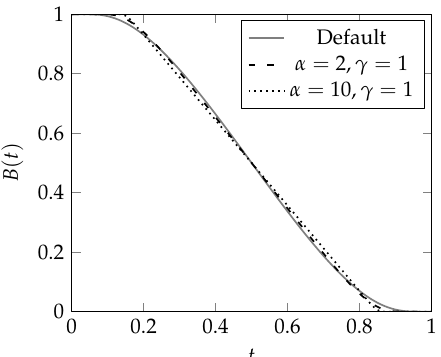
Figure 7. Plot of the default ERB-function. Figure 8. Plots of ERB-functions with Figure 8. Plots of Expo-rational blending functions (ERB-functions) with varying tightening parameters. varying tightening parameters. The solid The solid function is the default ERB ( α = γ = 1), the dashed function has α = 2 and γ = 1, and the function is the default ERB ( α = γ = 1), the dotted function has α = 10 and γ = dashed function has α = 2 and γ = 1, and Figure 9. Plots of ERB-functions with the dotted function has α = 10 and γ = 1. varying slope parameters. The solid function is the default ERB ( β = 1), the dashed function has β = 0.2, the dotted function has β = 10, and the dashdotted function has β = 50.